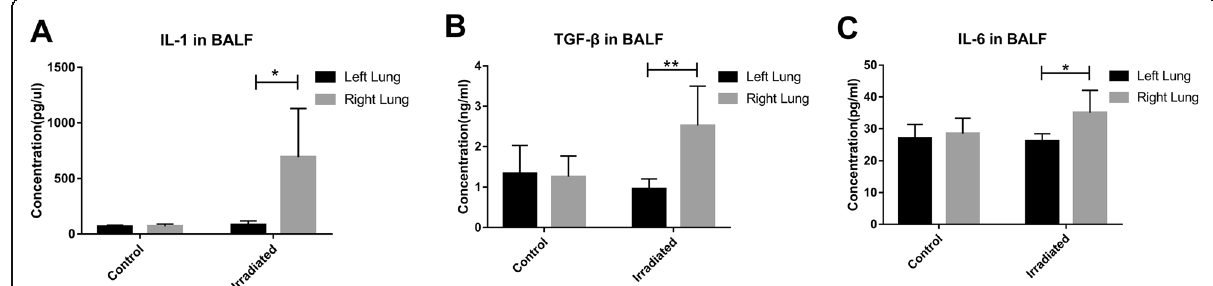
Fig. 1 Concentrations of inflammatory cytokines in bronchoalveolar lavage fluid (BALF) samples from the left and right lungs of control rats and